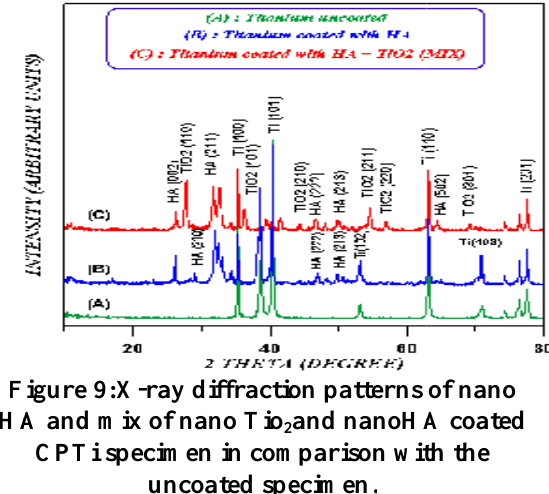
Figure 9:X-ray diffraction patterns of HA and mix